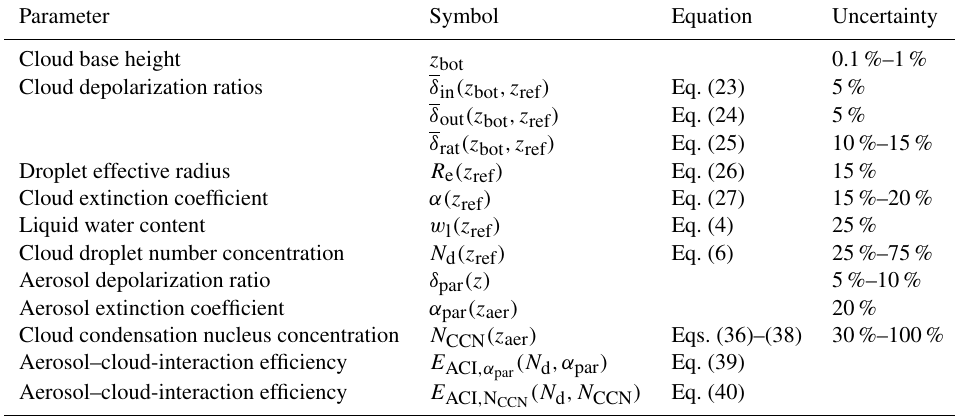
Table 3. Overview of the cloud and aerosol retrieval procedure (step-by-step data analysis). The data analysis starts with a precise determi- nation of the cloud base height z bot . The cloud products are given at the reference height z ref , 75m above the cloud base height z bot . In the estimation of the ACI efficiency, particle extinction and cloud condensation nucleus concentration at z aer , usually several hundreds of meters below the cloud base, are